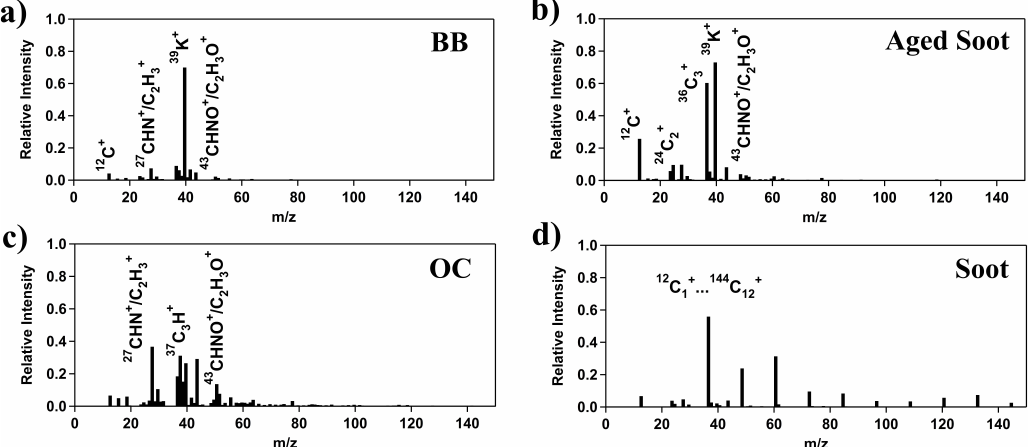
Fig. 3. A-ATOFMS particle types for the main carbonaceous species, (a) biomass burning (BB), (b) soot mixed with organic carbon (Aged Soot), (c) organic carbon (OC), and (d) soot. A wide array of negative ions, indicative of secondary species, were observed on these particle sources, hence are not shown here, but common negative ions are discussed in text and can be found in Fig.